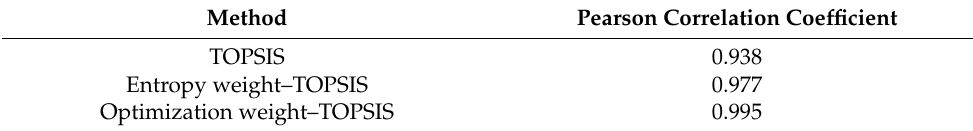
Table 10. Pearson correlation